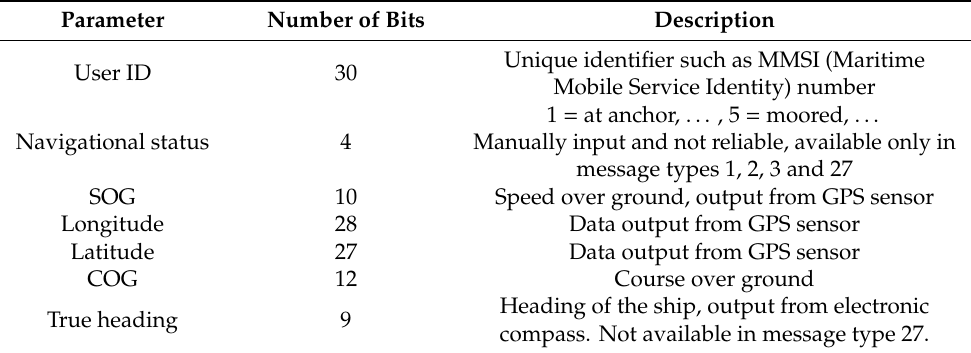
Table 1. Primary parameters in position reports (kinematic messages) of Automatic Identification Systems